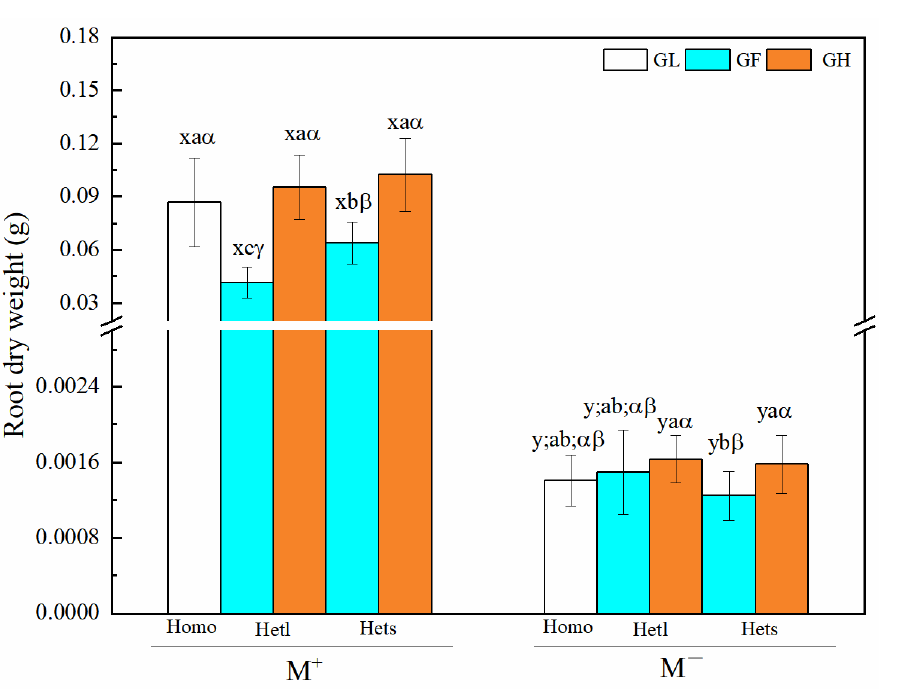
Figure 2. The dry weight of B. pilosa roots. Abbreviations: M + = B. pilosa was inoculated with a mycorrhizal fungus. M − = B. pilosa was not inoculated with a mycorrhizal fungus. Homo = homogeneous patch. Hetl = heterogeneous-large patch. Hets = heterogeneous-small patch. GL = gravel-low substrate. GF = gravel-free substrate. GH = gravel-high substrate. The dif- ferent lowercase letters (x, y) indicate significant differences between M + and M − treatments of B. pilosa ( p ≤ 0.05). The different lowercase letters (a–c) indicate significant differences between Homo, Hetl, and Hets patches ( p ≤ 0.05); The different lowercase letters ( α – γ ) indicate significant differences between GL, GF, and GH substrates ( p ≤ 0.05). The error bars represent the standard deviation